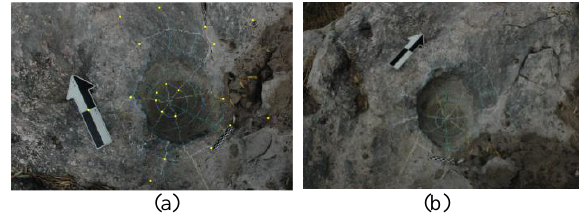
Figure 6. Images used for the reconstruction, along with sampled points for generating the initial coarse surface.